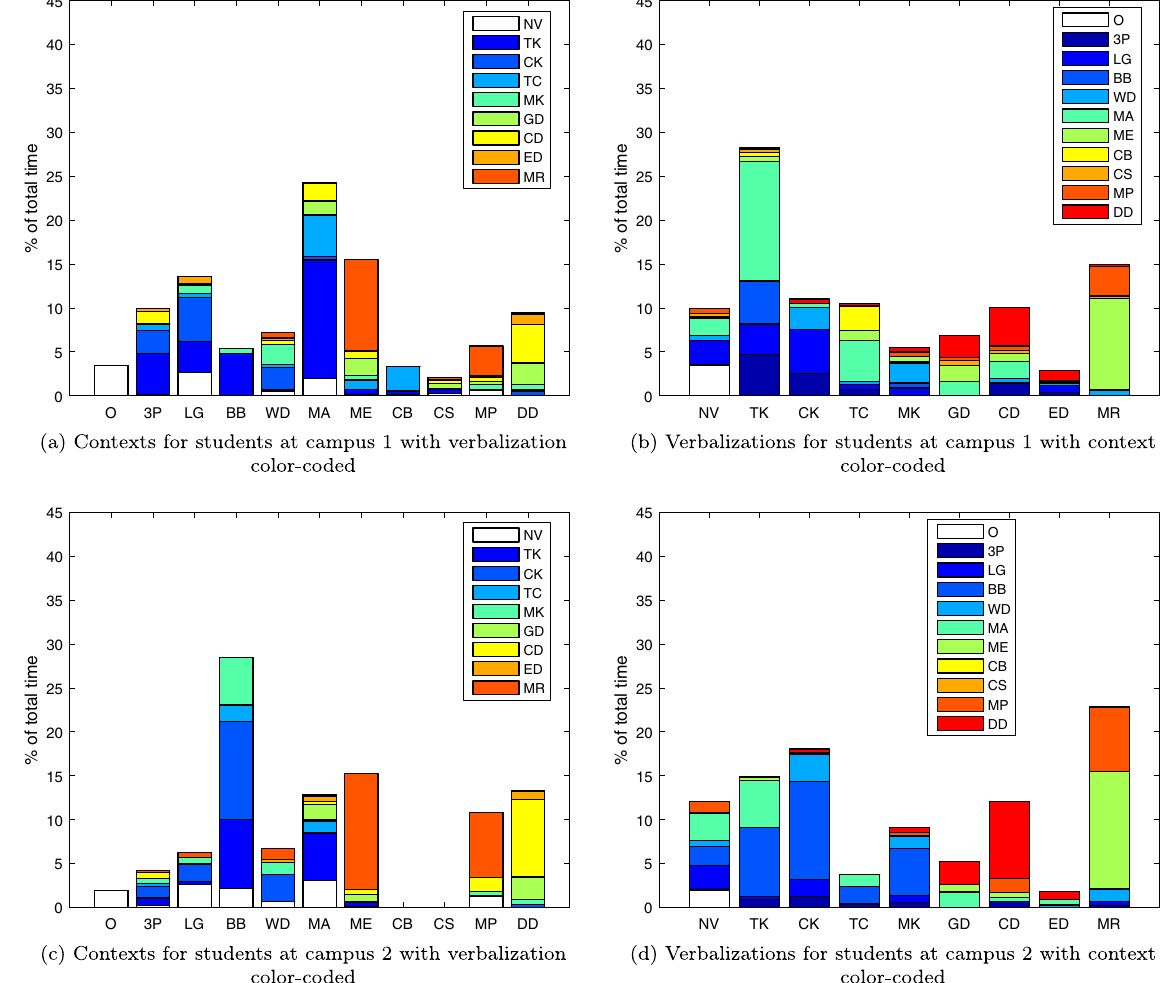
FIG. 9. Results of final labs. All percentages are the total of all pairs at the different campuses. Left are contexts with verbalization marked by colors (a) and (c), while right are verbalizations with the contexts marked by colors (b) and (d). The rows are campus 1 [(a) and (b)] and campus 3 [(c) and (d)],